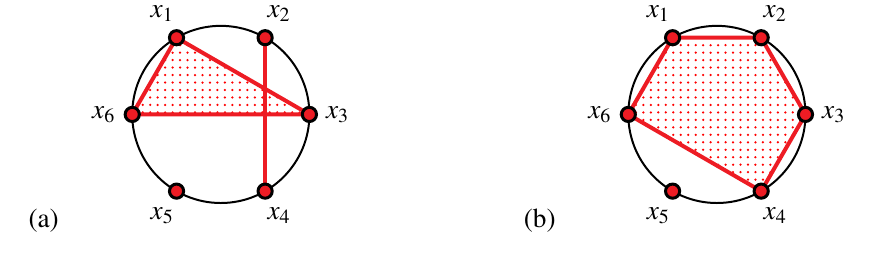
Figure 2: Configuration (a) cannot happen when the equivalence relation is “belonging to the same nodal domain".